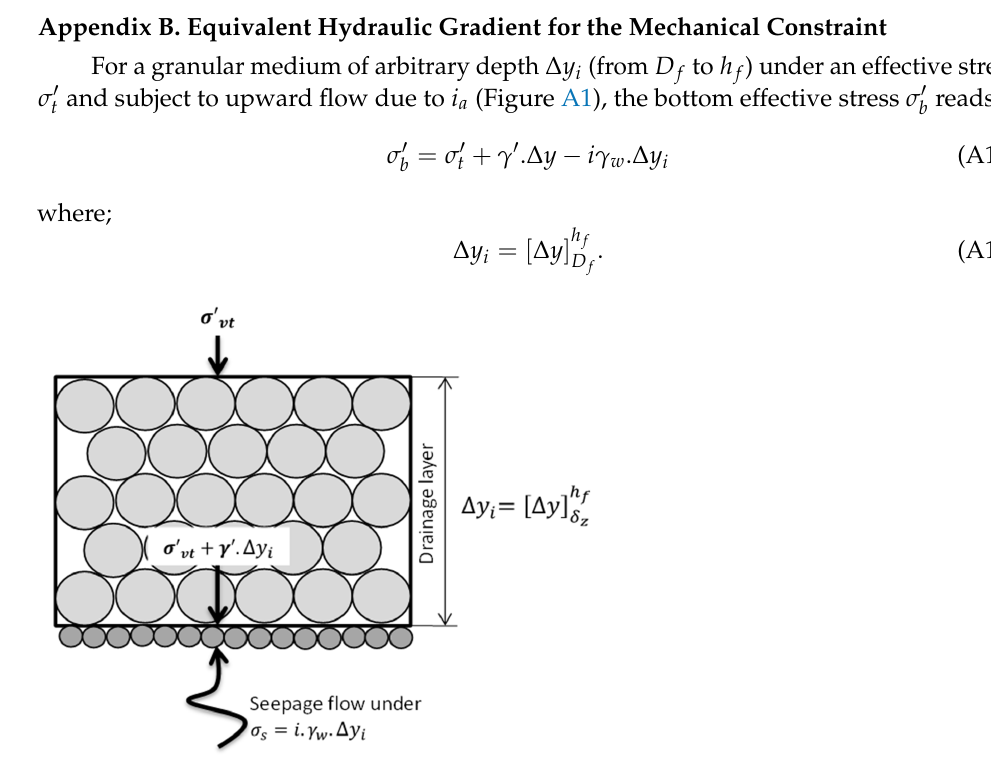
Figure A1. Vertical effective stresses on soil volume subject to the upward seepage flow.